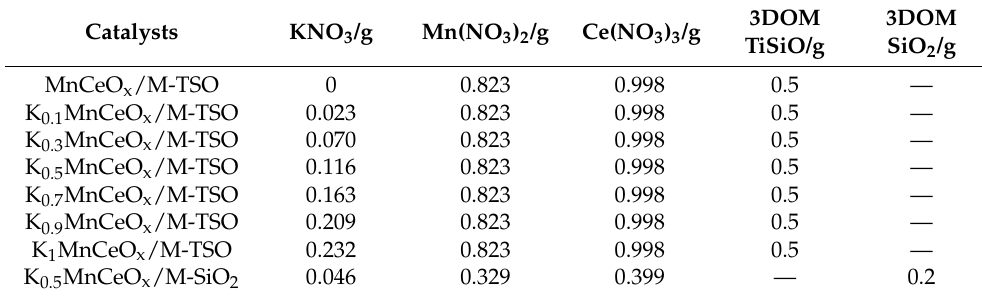
Table 1. Expression of catalyst and amount of raw